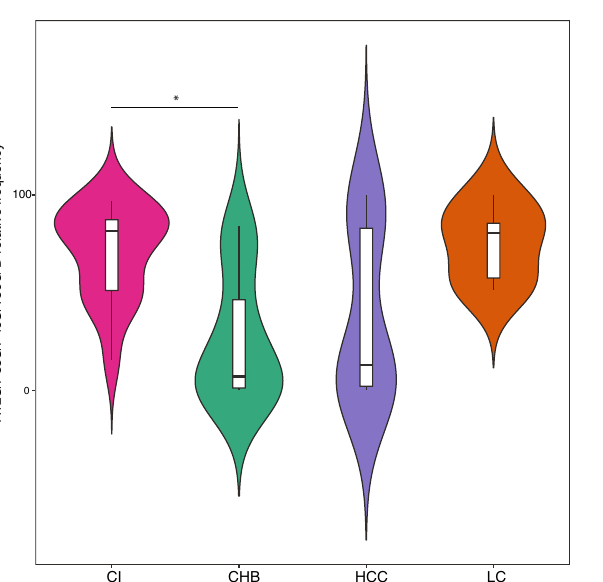
Figure 3. Pattern of mutations in genotype D haplotypes. ( a ) Spearman correlation between the frequencies of the amino acid changes highlighted in genotype D haplotypes. Each dot represents the change’s frequency in each patient. Rho and p values are reported. ( b ) Hierarchical cluster dendrogram of the observed mutations. The y-axis is a measure of closeness of an individual mutation or a cluster.